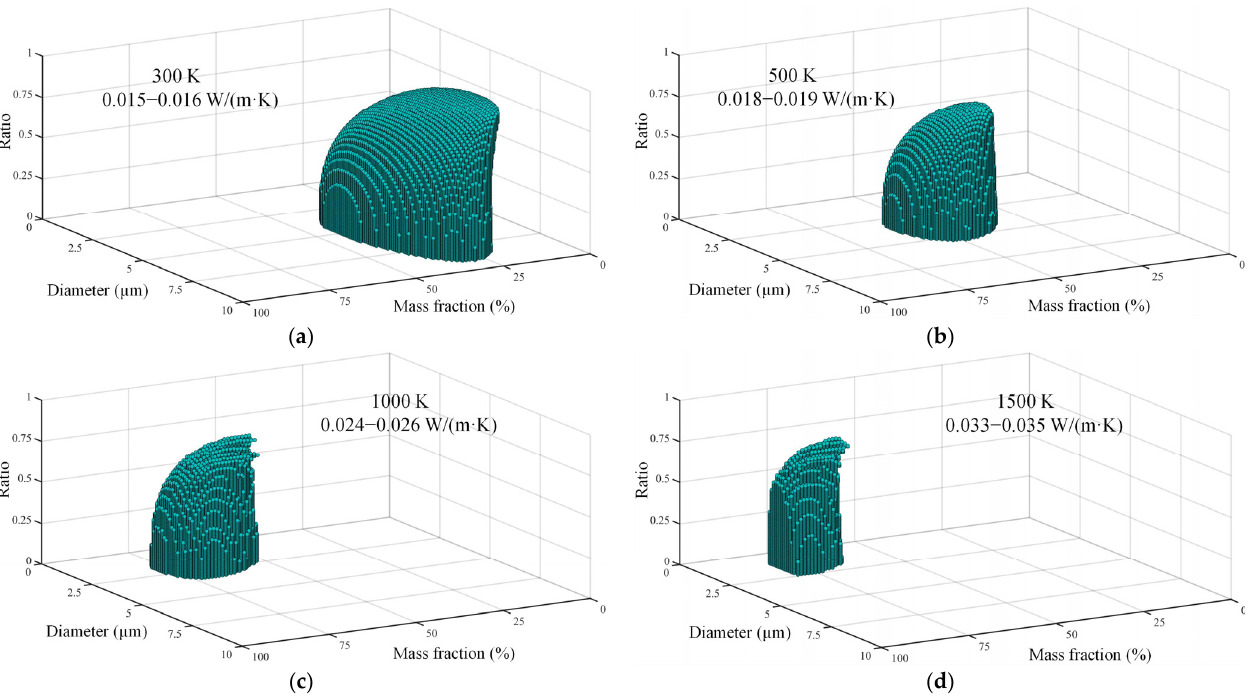
Figure 7. Optimization of geometric parameters of silica aerogel doped with hollow spheres at various temperatures. ( a ) Optimized geometric structures with minimized total thermal conductivity at 300 K. ( b ) Optimized geometric structures with minimized total thermal conductivity at 500 K. ( c ) Optimized geometric structures with minimized total thermal conductivity at 1000 K. ( d ) Optimized geometric structures with minimized total thermal conductivity at 1500 K.